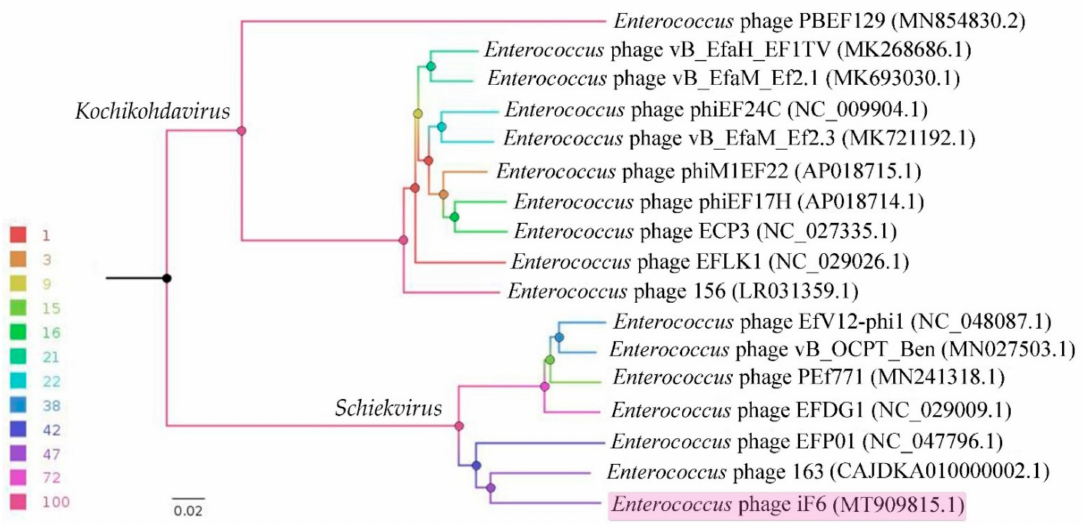
Figure 6. Genome-BLAST Distance Phylogeny (GBDP) phylogram based on the amino-acid sequences of the whole phage proteomes and inferred using formula D6. The nodes are colored according to the legend representing GBDP pseudo-bootstrap support values from 100 replications. The branch lengths are scaled in terms of the GBDP distance (formula D6). The Enterococcus phage iF6 is highlighted in light